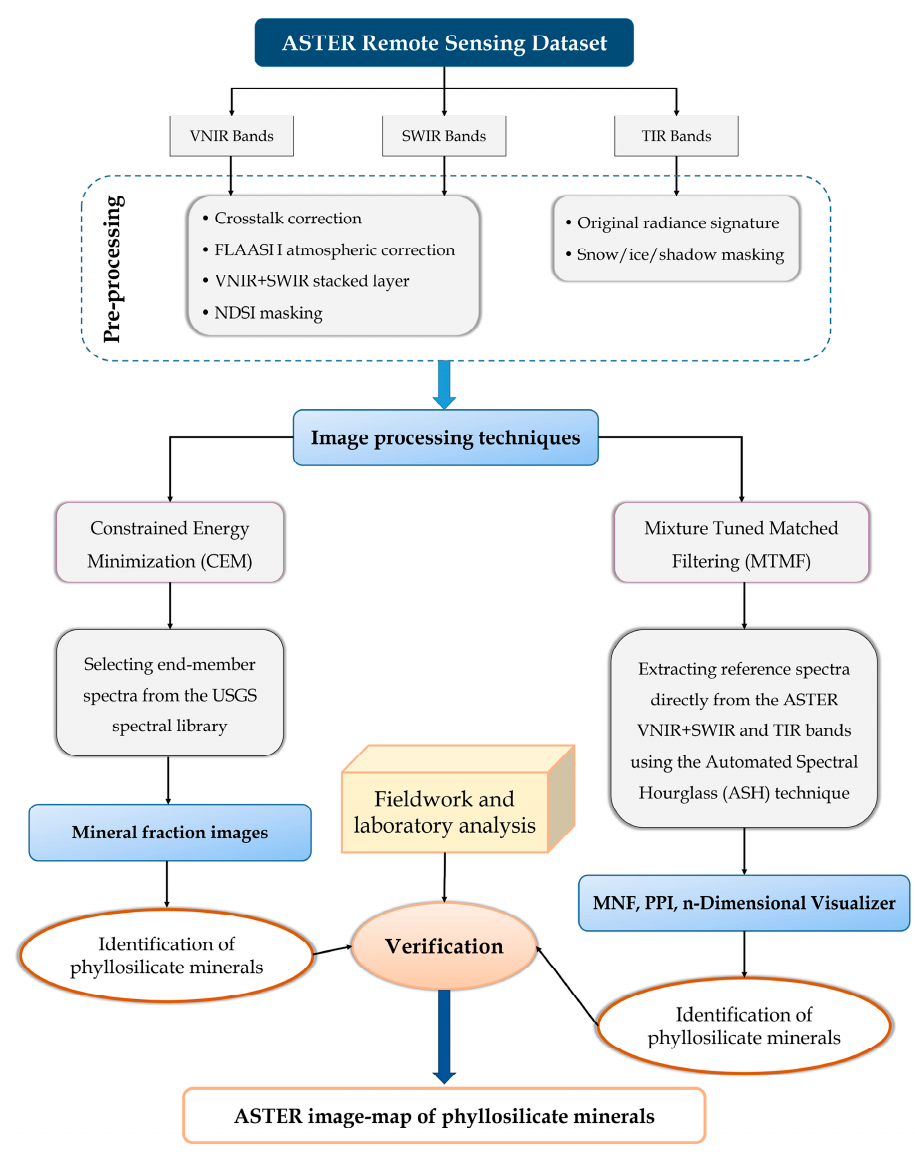
FIG 3 Figure 3. An overview of methodological flowchart used in this